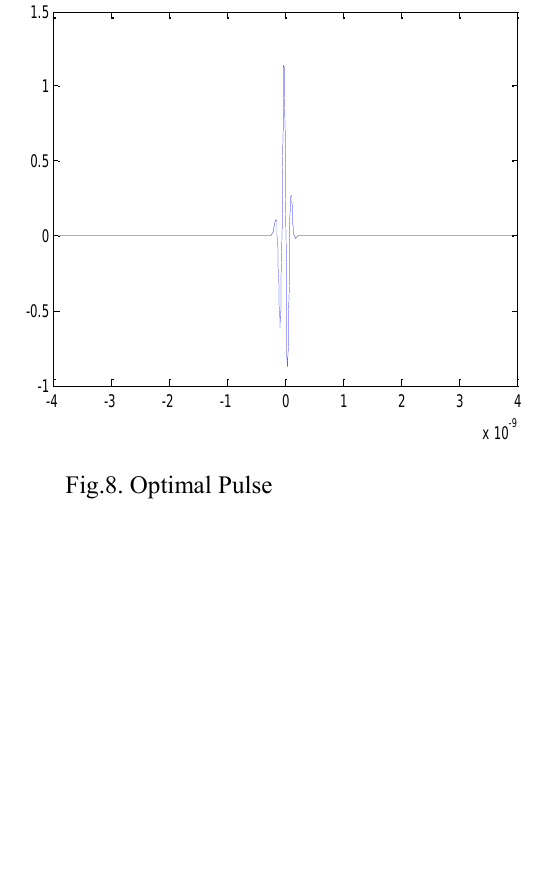
Fig.7. PSD for 5 th derivative Gaussian Pulse Fig. 7 shows the fifth optimal derivative of Gaussian pulse with the obtained pulse shape factor value of 0.177 × 10 -9 s given in Table 2 matches the emission mask more closely as compared to the other nearby taken values of the pulse shaping factors of 0.157 × 10 -9 s, 0.197 × 10 -9 s, 0.217 × 10 -9 s which shows that the obtained pulse shape factor value is optimal and are in accordance with the EIRP emission mask limits.